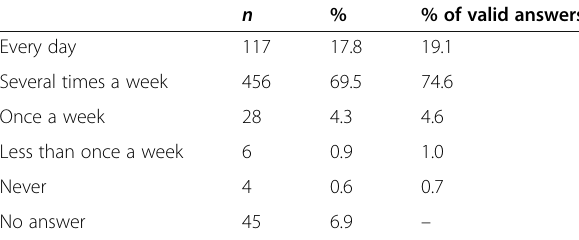
Table 4 The percentage division of children aged 10 – 13 depending on the frequency of their consumption of meat n